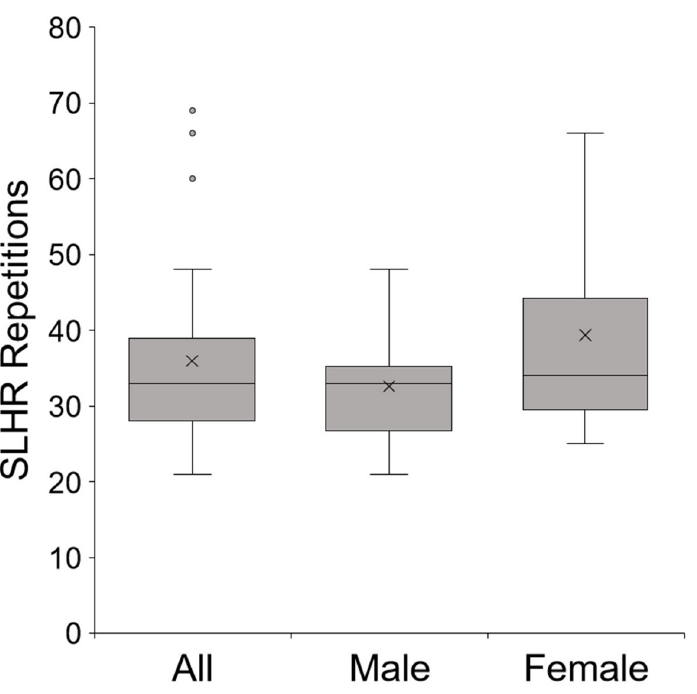
Fig 2. Box-and-whisker plot of single-leg heel raise (SLHR) repetitions performed by males and females. The middle line represents the median values, while the “x” represents the mean values. The left-hand box shows the pooled results for males and females. There were no sex differences in number of SLHR repetitions completed at time of task failure (p = 0.137). in MVIC was similar between males and females ( p = 0.532). Furthermore, body weight did ( p = 0.206).